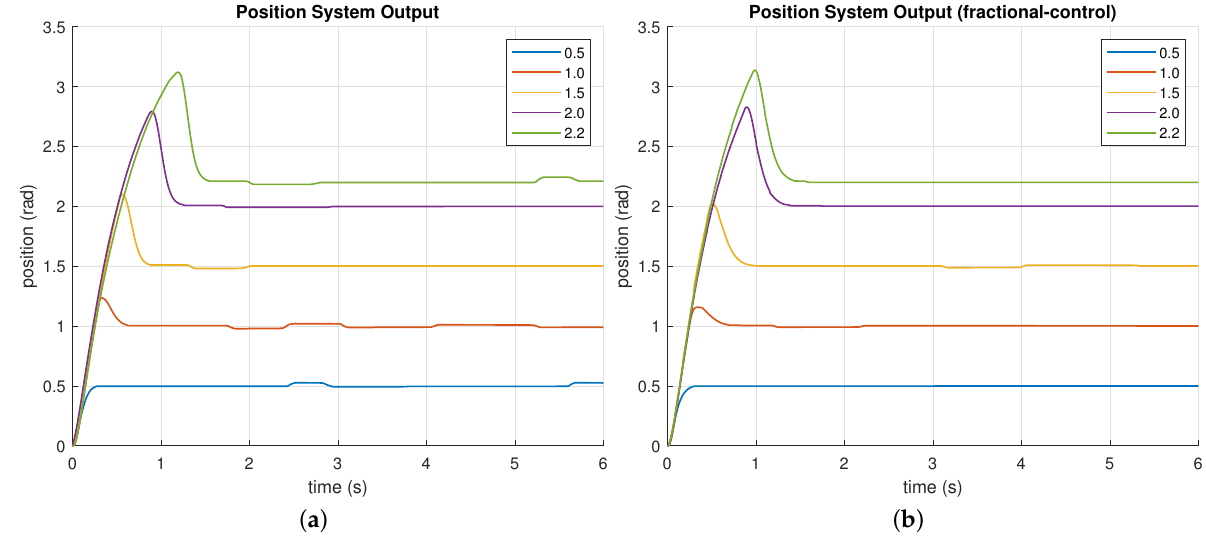
Figure 20. Test results with different target positions. ( a ) Integer controller. ( b ) Fractional controller.